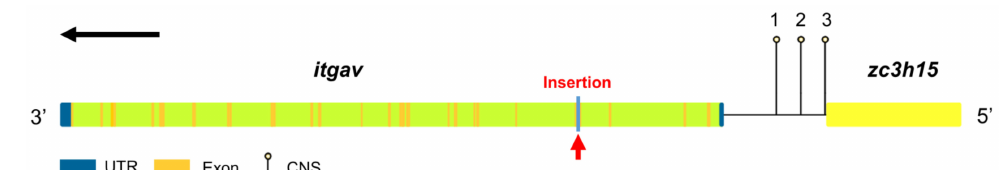
Figure 5. Itgav structural map. The red arrow indicates the insertion site of the ET vector. The black arrow indicates the orientation of the gene itgav . Numbers 1, 2, 3 indicate three conserved non-coding sequences (CNS) located upstream of itgav or downstream of zc3h15 . UTR: untranslated region; CNS: conserved non-coding sequence.